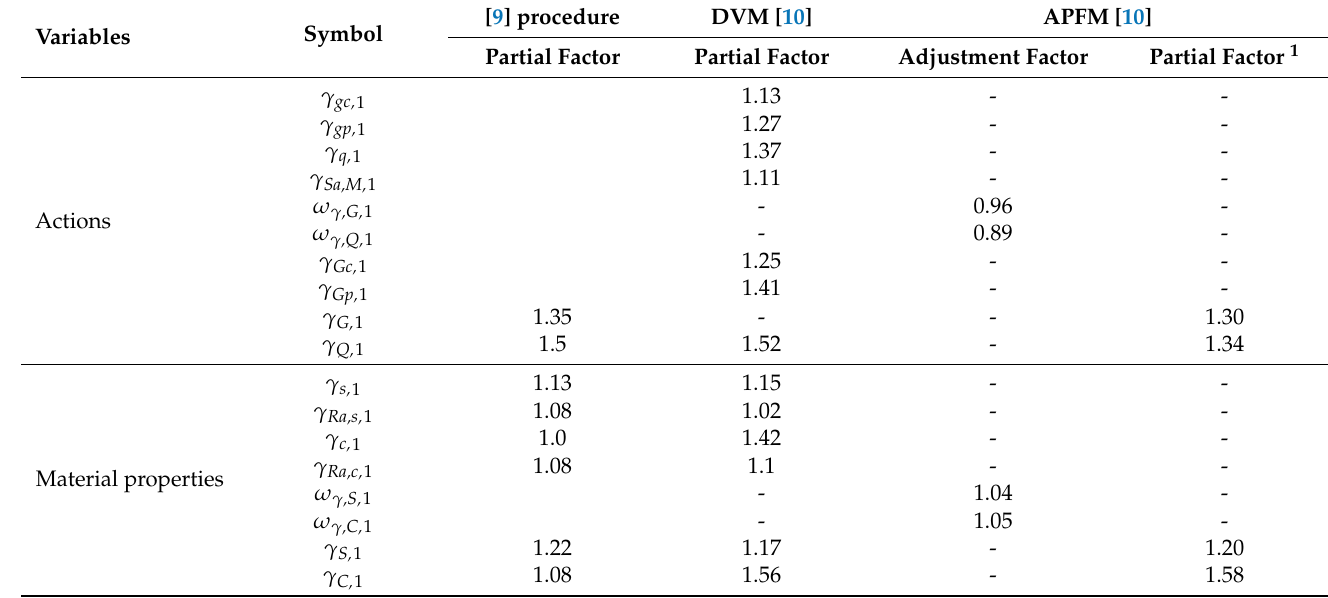
Table 5. Partial factors for the first stage of the assessment.